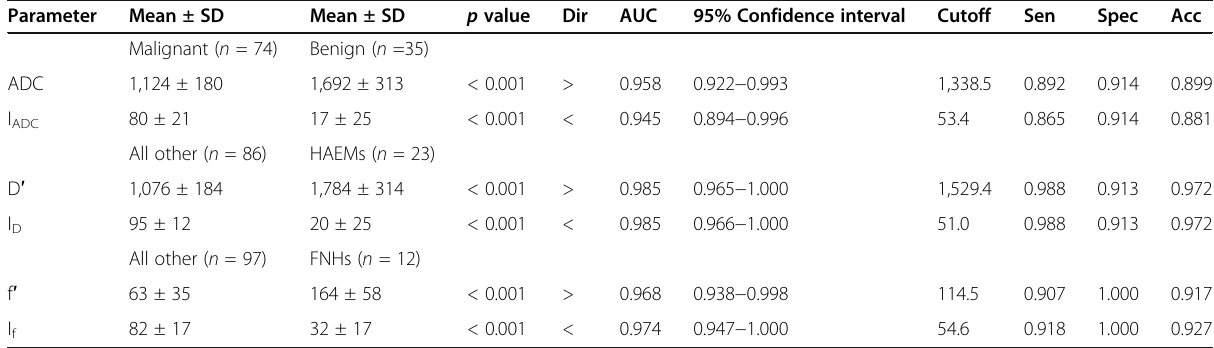
Table. 3 Receiver operating characteristic analysis for construction of index maps